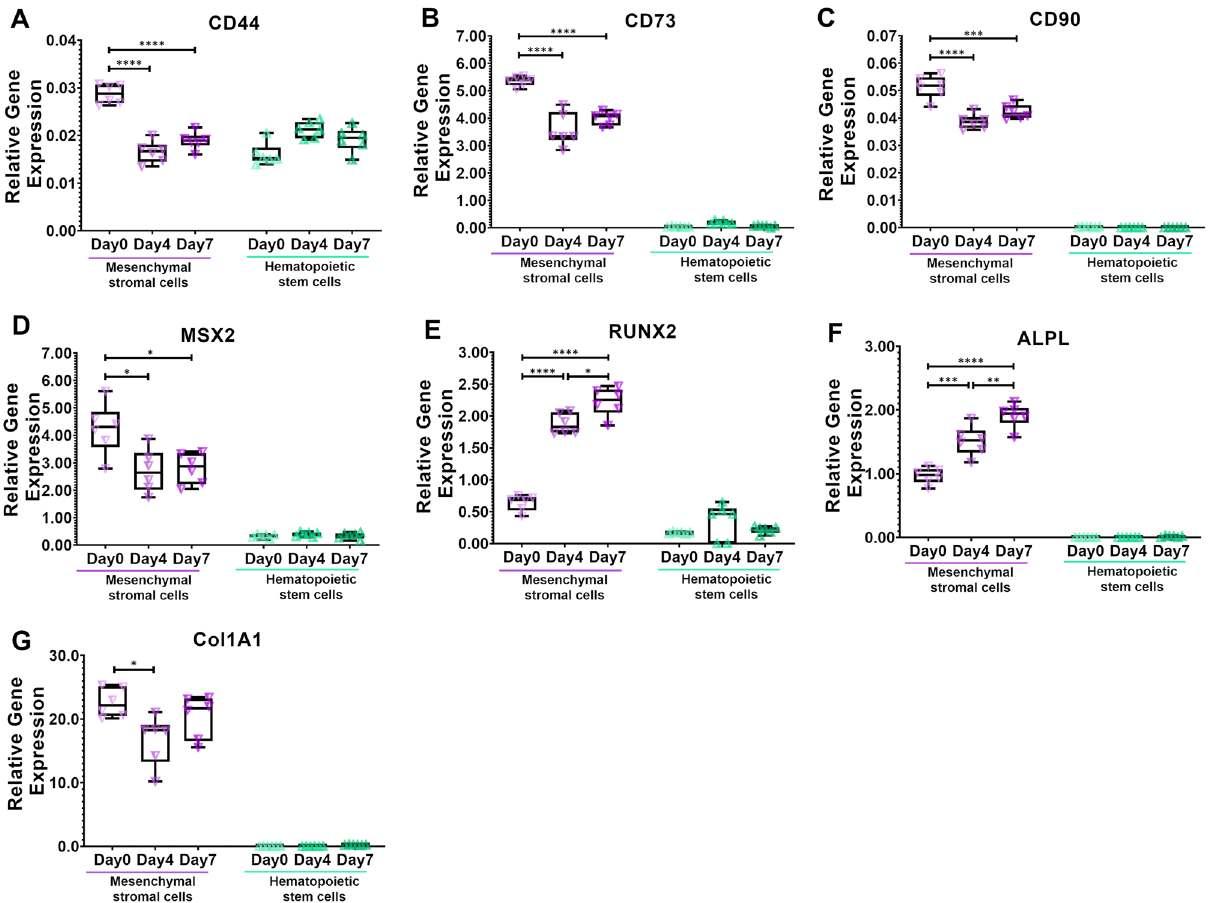
Figure 2. The induction of osteogenic differentiation of mesenchymal stromal cells was verified by gene expression analysis. ( A–D ) Mesenchymal stromal cells (Day 0) were identified by an increased expression of ( A ) Hematopoietic Cell E- And L-Selectin Ligand (CD44), ( B ) 5’-Nucleotidase Ecto (CD73), ( C ) Thy-1 Membrane Glycoprotein (CD90), and ( D ) Homeobox Protein Hox-8 (MSX2). ( E–G ) Induction of osteogenic differentiation into osteoprogenitors (Day 4) and early pre-osteoblasts (Day7) were verified by continuously increasing expression in genes related to osteoblast differentiation: ( E ) Runt-Related Transcription Factor 2 (RUNX2), ( F) Alkaline Phosphatase Liver/Bone/Kidney Isozyme (ALPL), and Collagen Type I Alpha 1 Chain (Col1A1). *p<0.05, **p<0.01, ***p<0.001, ****p<0.0001, one-way analysis of variance with Bonferroni post hoc test. n=6 individual